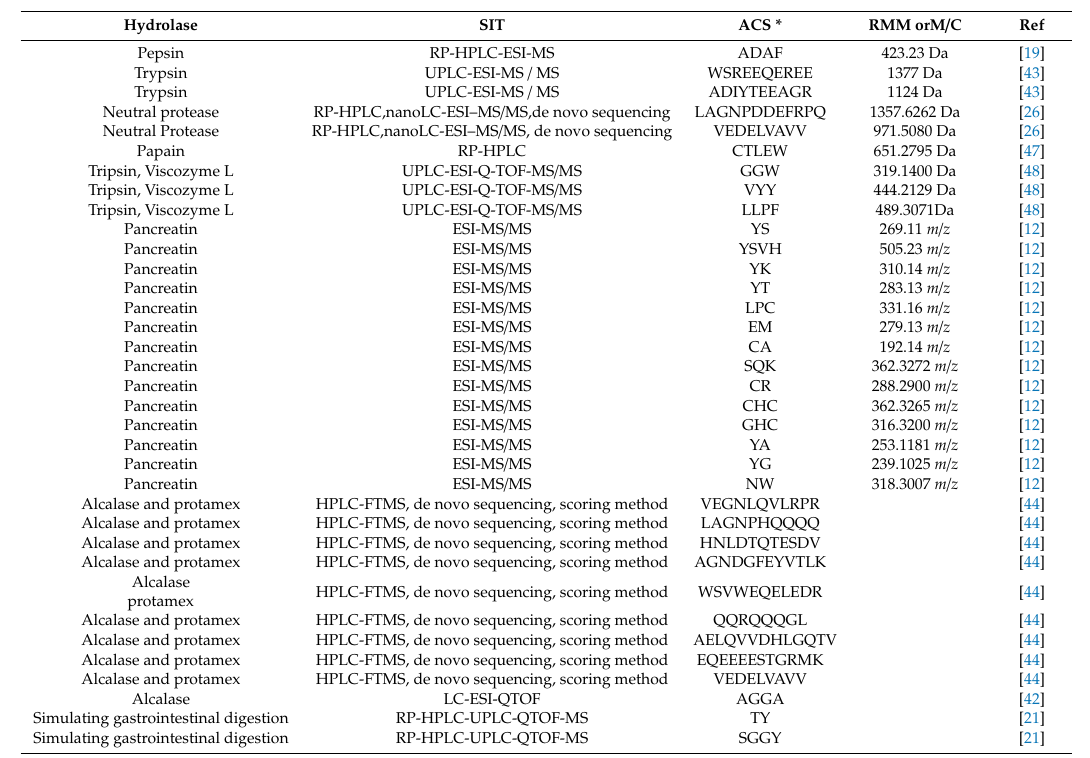
Table 2. Some walnut antioxidant peptides that have been